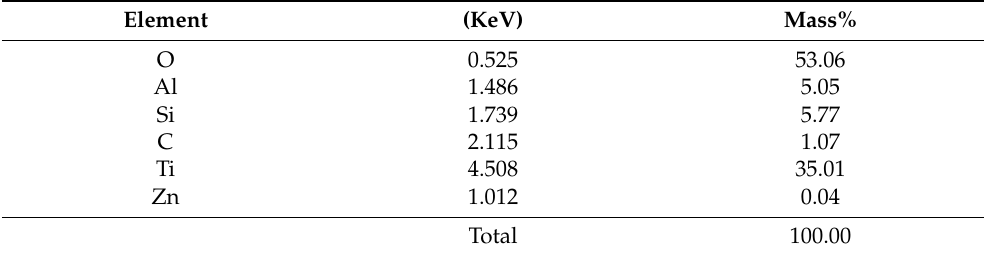
Table 2. Elemental composition of the novel nanohybrid confirmed by EDS